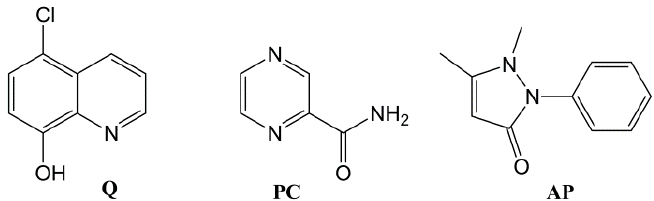
Figure 3. Chemical structures of the chosen drugs: 5-chloro-8-hydroxyquinoline ( Q ), pyrazinecarboxamide ( PC ), and antipyrine ( AP